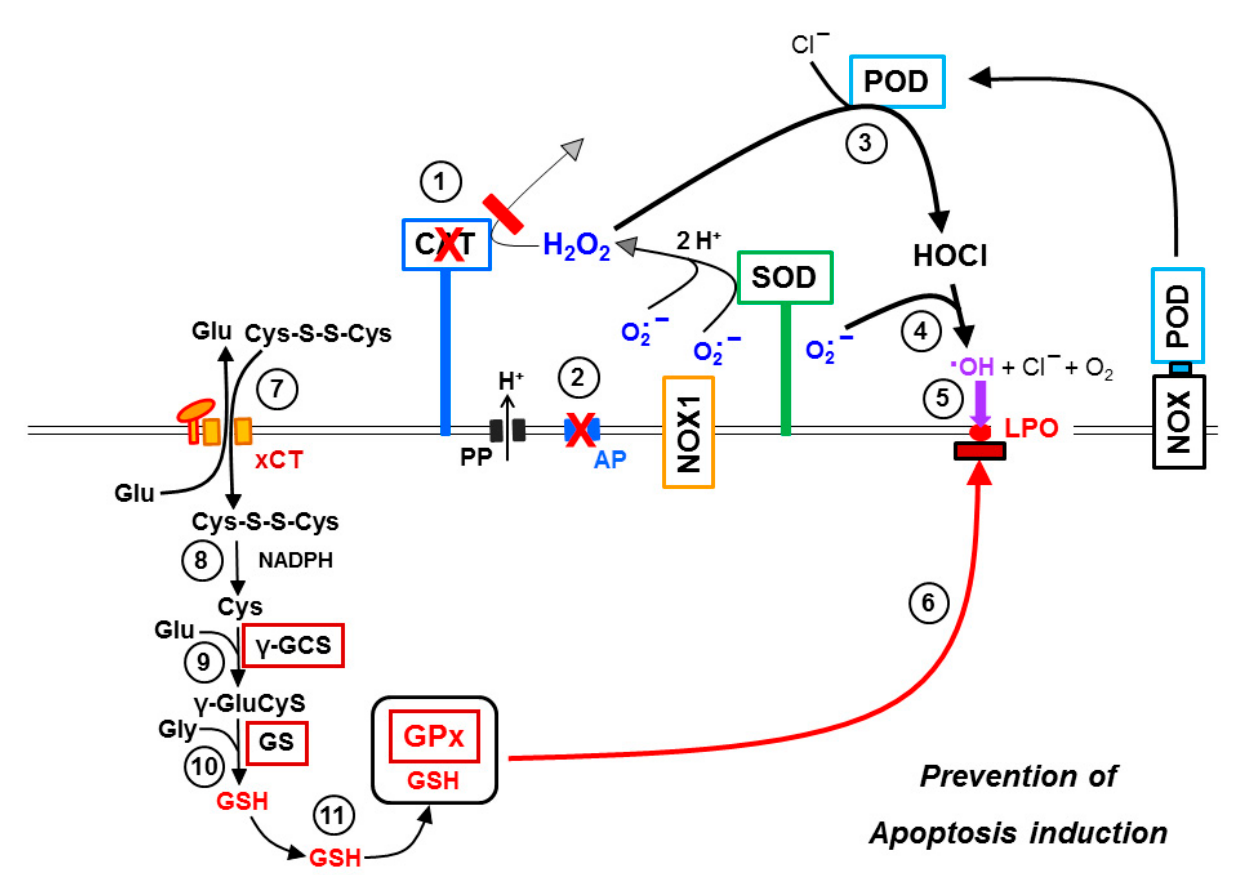
Figure 14. Consequences of parallel inhibition of catalase and aquaporins. When catalase (#1) and aquaporins (#2) are inhibited in parallel, apoptosis induction is prevented despite activated HOCl signaling (#3–5), as GPX/GSH actively interferes with the consequences of lipid peroxidation (#6). This interaction is sustained, as GPx/GSH is not attacked by intruding H 2 O 2 , due to the inhibition of aquaporins.